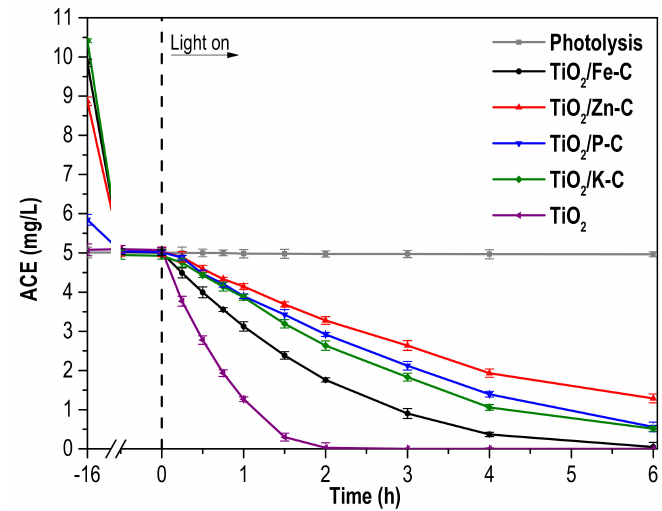
Figure 6. Acetaminophen (ACE) concentration versus time under solar irradiation with TiO 2 and TiO 2 /x-C heterostructures ([Photocatalyst] 0 : 250 mg · L − 1 of TiO 2 ; [ACE] 0 after adsorption equilibrium: 5 mg · L − 1 ; intensity of irradiation: 600 W · m − 2 ).